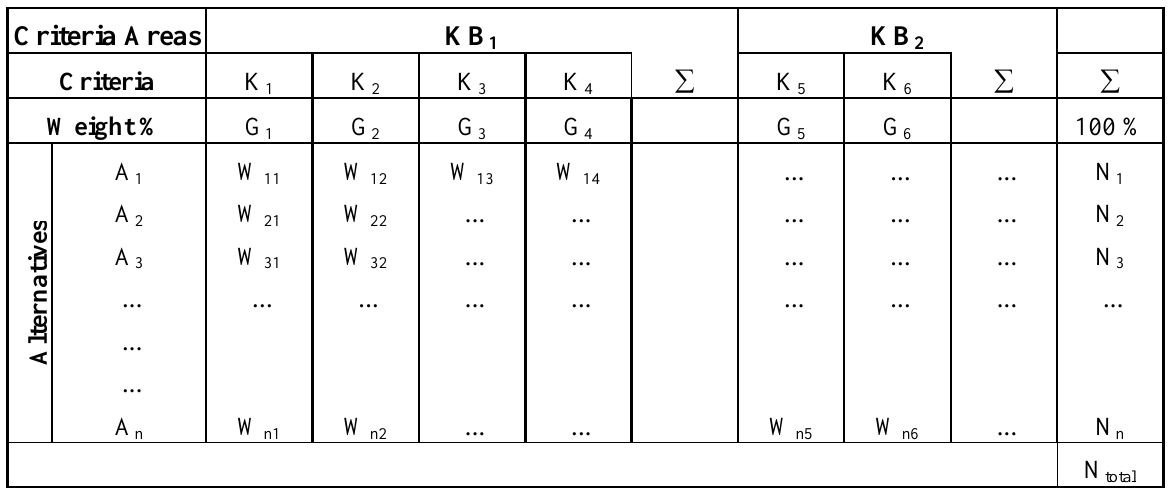
Table 2. Linear notation of a goal-value matrix